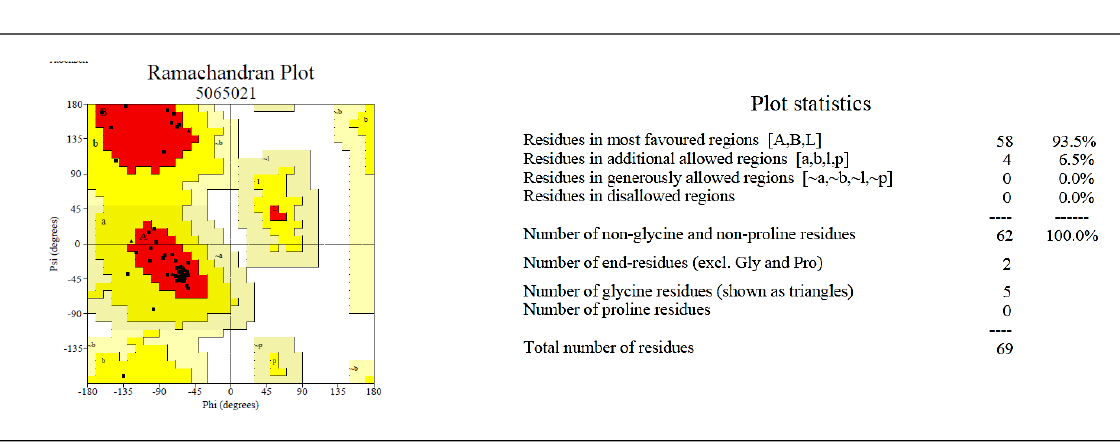
Figure 12: a: Ramachandran Plot and b: Plot Statistics of the Mc Squlaene Synthase (McSQS) using PROCHECK indicating the allowed and restricted region of the predicted